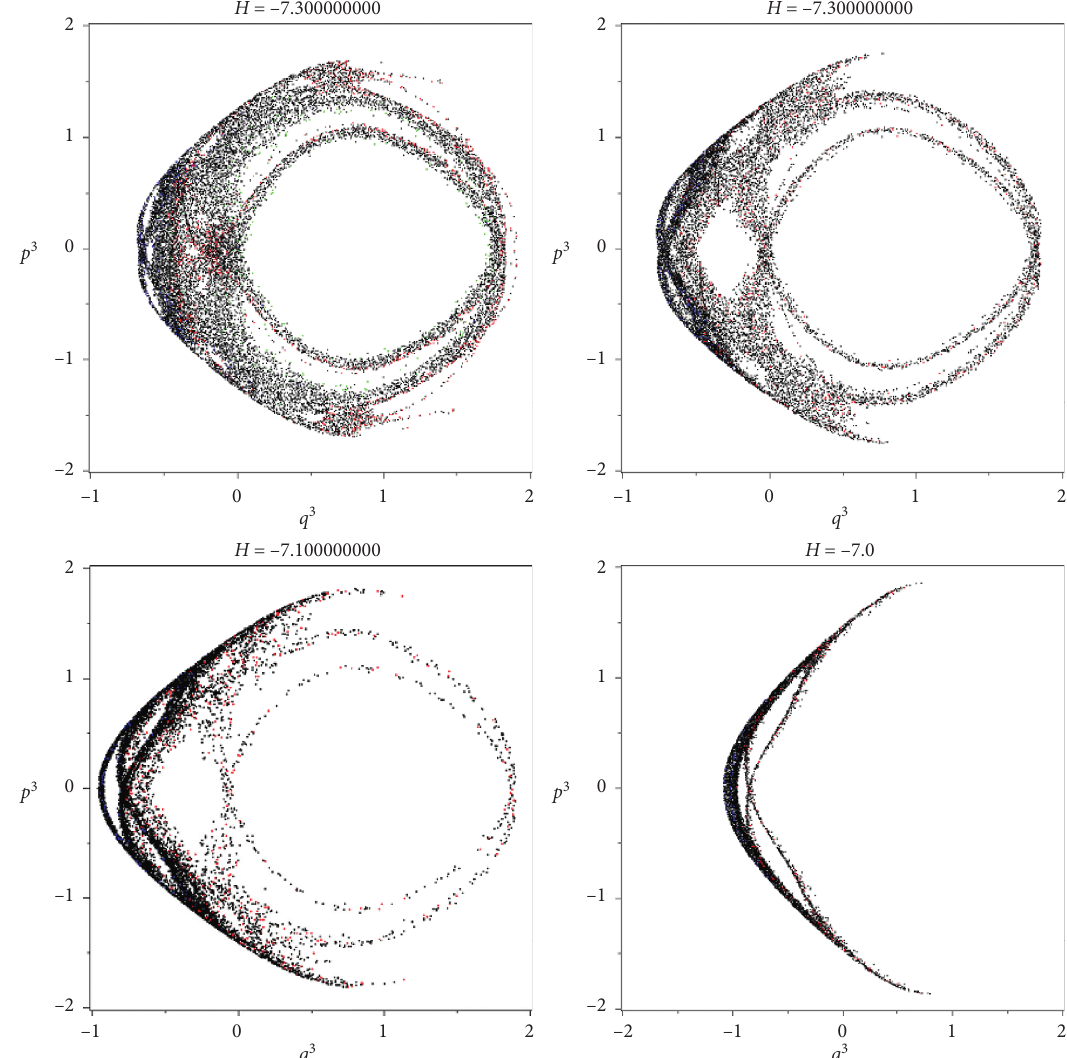
Figure 14: The progressive changing of a Poincar´e surface of sections for different energy levels in the unequal masses case ( m � 1 . 03, m � m � 1, b � 1 . 9, and c � 0 . m 2 3 1